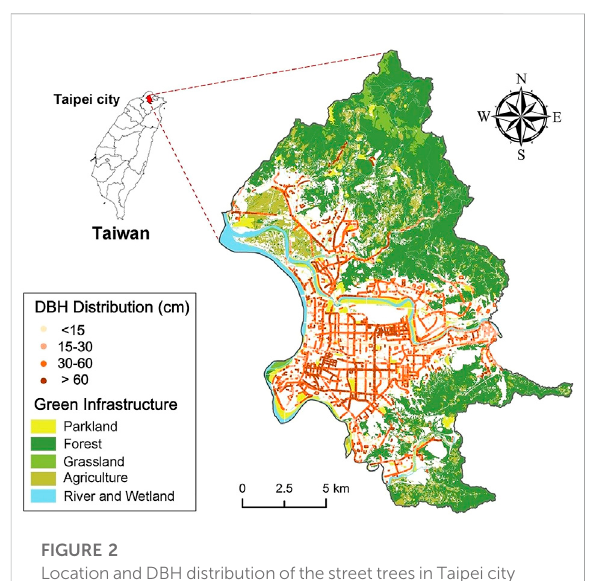
FIGURE 2 LocationandDBHdistributionofthestreettreesinTaipeicity with local green infrastructure